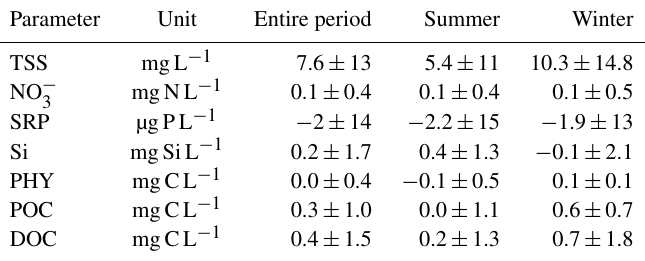
Table 2. Model performances (bias ± SD errors) for different timescales: over the entire period of validation (1 August 2012 to 31 July 2014), in summer (April to October) and in winter (November to March). Parameter Unit Entire period Summer